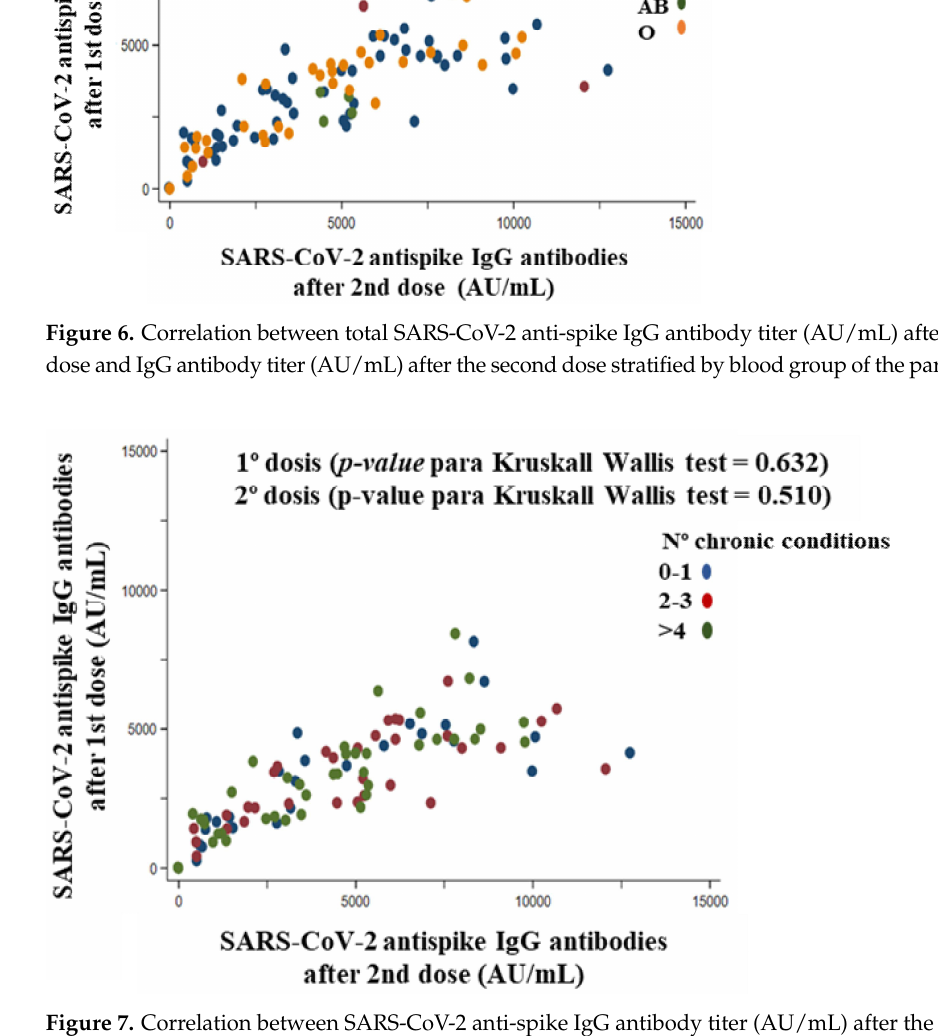
Figure 7. Correlation between SARS-CoV-2 anti-spike IgG antibody titer (AU/mL) after the first dose and IgG antibody titer (AU/mL) after the second dose stratified by the number of chronic conditions of the